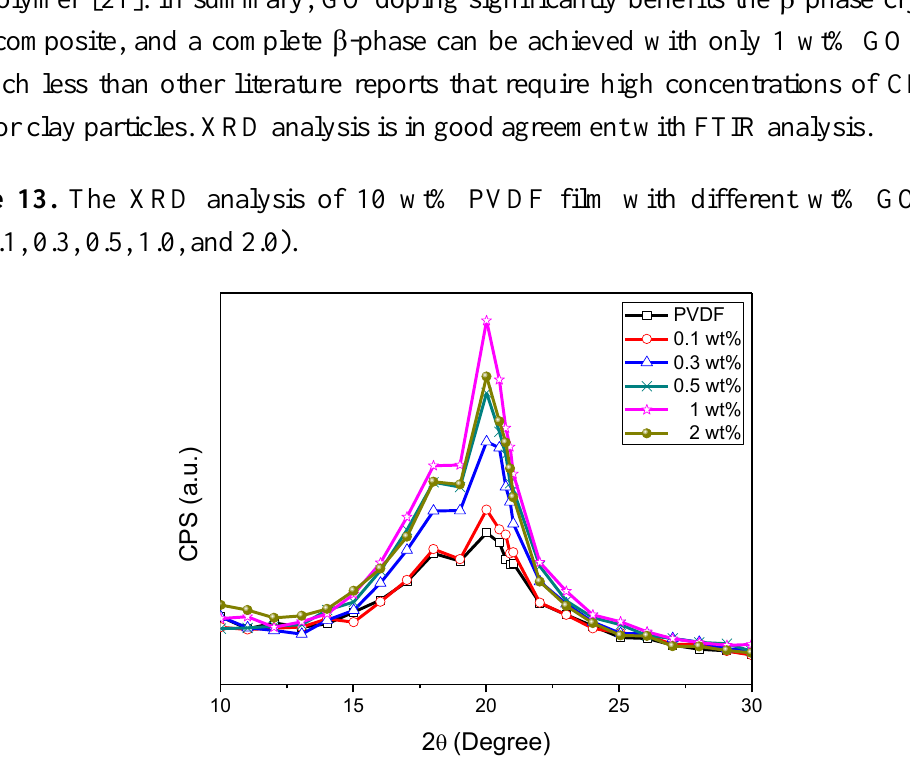
Figure 14. The FTIR analysis of 10 wt% PVDF film with different wt% GO doping (0, 0.1, 0.3, 0.5, 1.0, and